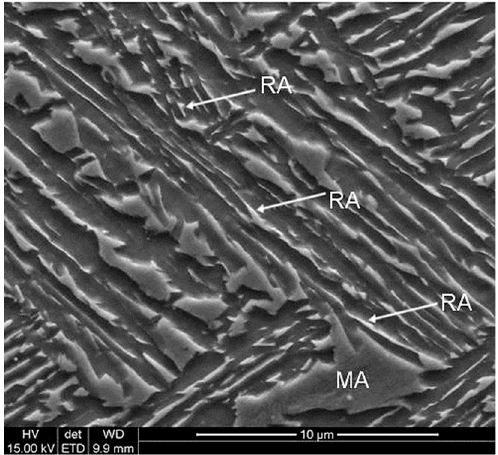
Figure 1. SEM micrograph of the specimen in the initial state (undeformed) characterized by bainitic ferrite laths containing retained austenite (RA) and martensite–austenite (MA) constituents.